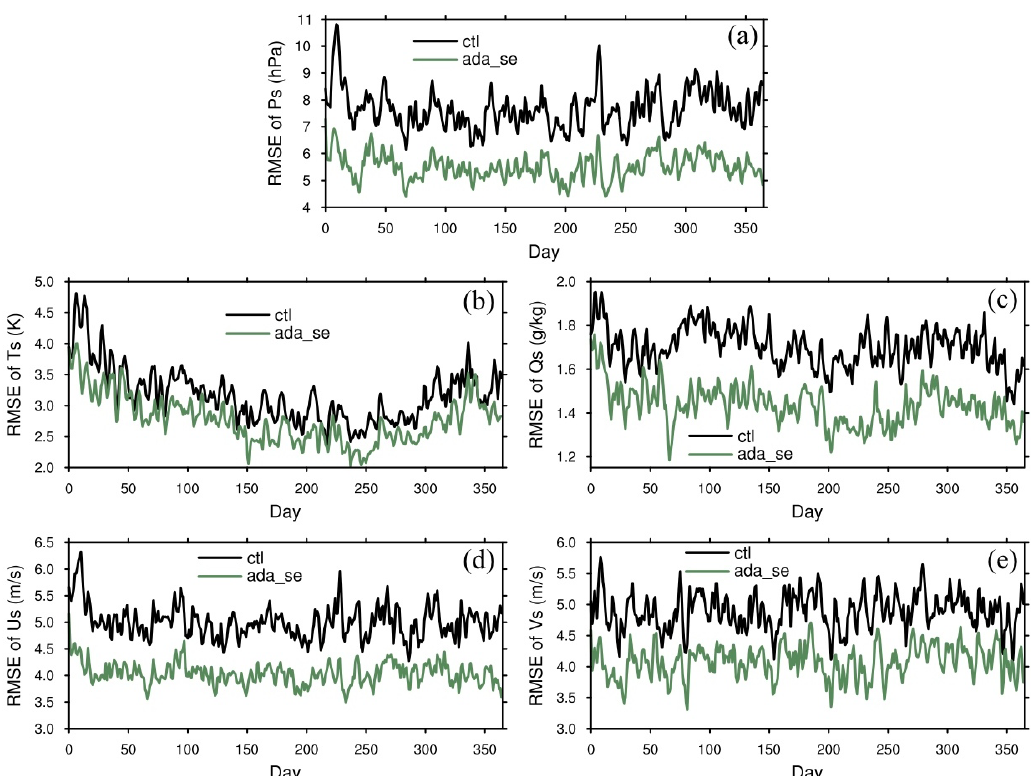
Figure 6. Time series of RMSEs of (a) surface pressure P s , (b) surface temperature T s , (c) surface specific humidity Q s , (d) surface zonal wind U s , and (e) surface meridional wind V s from ctl and